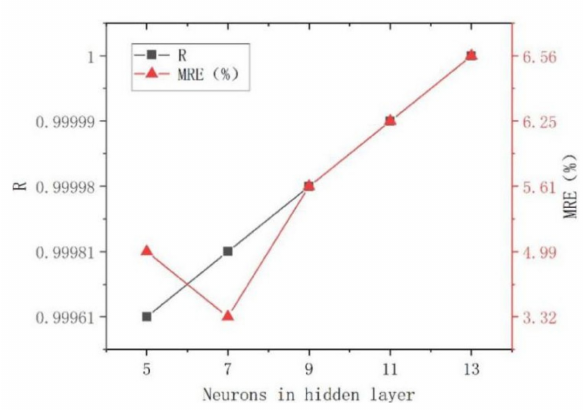
Figure 8. Mean-relative-error (MRE) and R values of di ff erent neurons numbers in the hidden